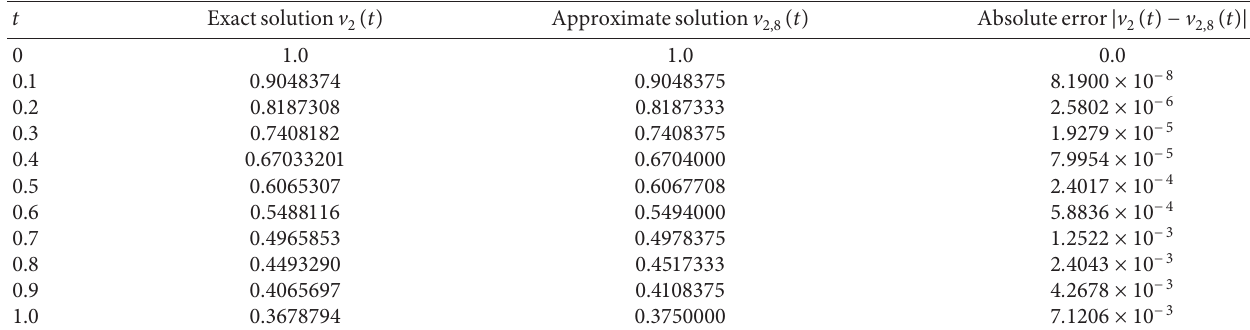
( t ) and approximate v ( t ) solutions for Example 1 at β � 1 and k � 8 over the interval [0, 2 2 , 8